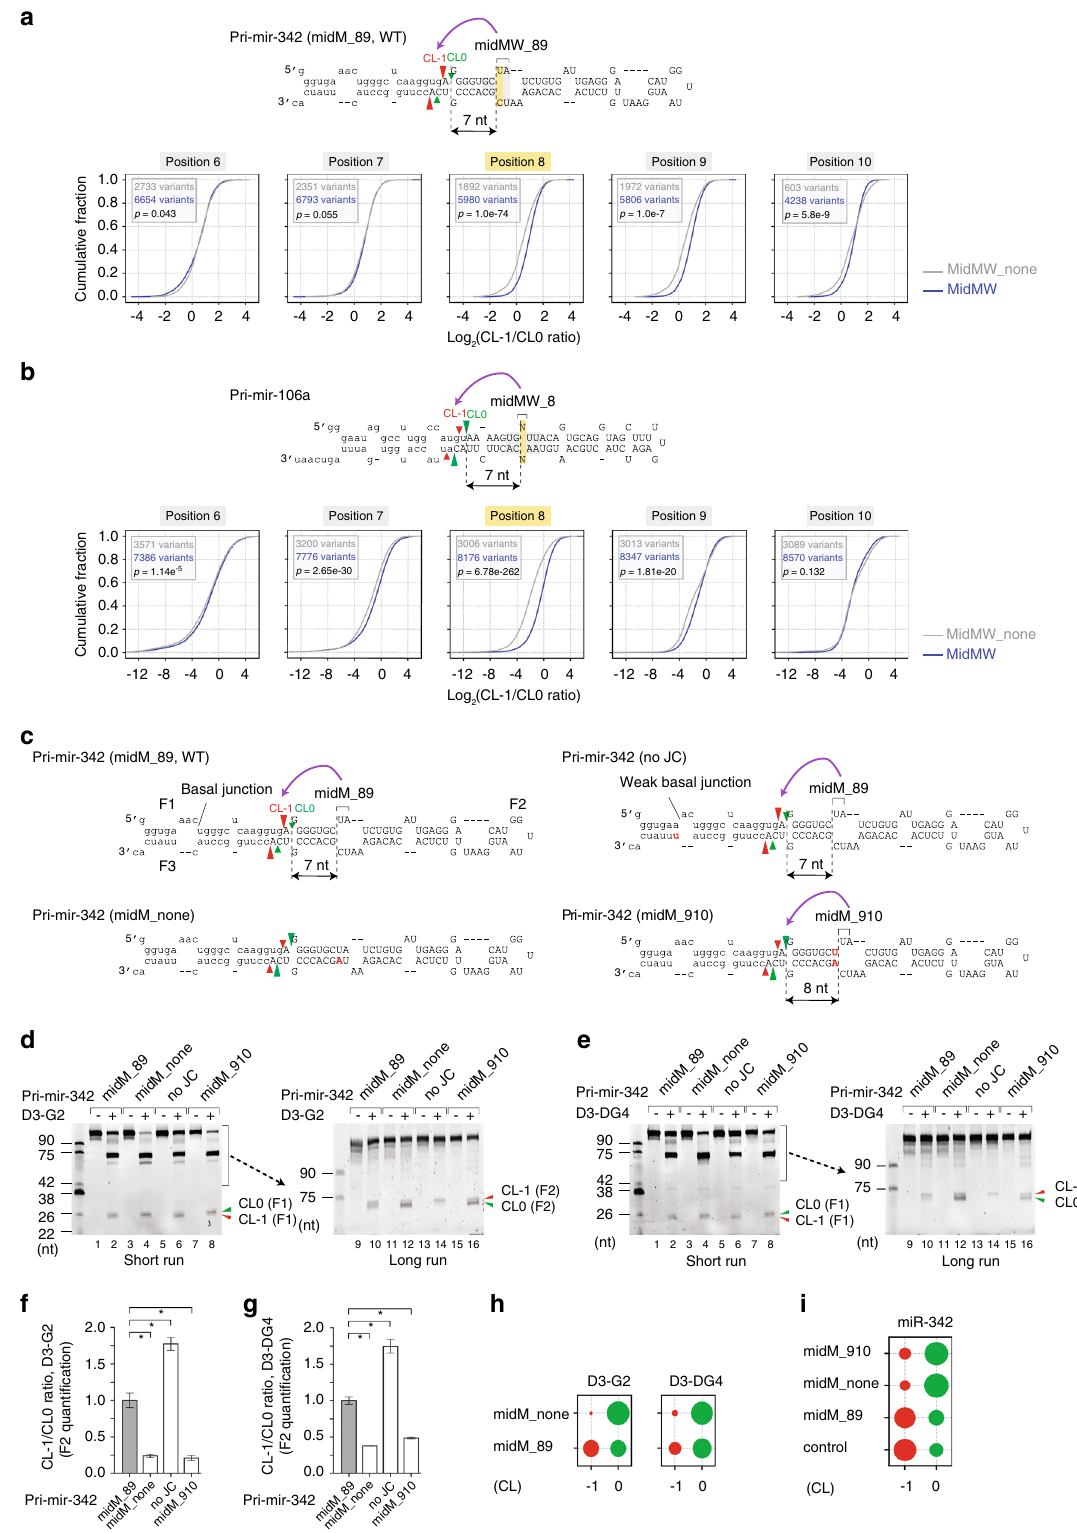
positions 1 – 13, with that of their corresponding matched var- iants. The results showed that a mismatch within positions 4 – 8 signi fi cantly reduced the activity of DROSHA (Fig. 5a). Further analysis showed that double and triple mismatches within the 4 – 8 region further decreased the enzymatic activity of DROSHA (Fig. 5b).